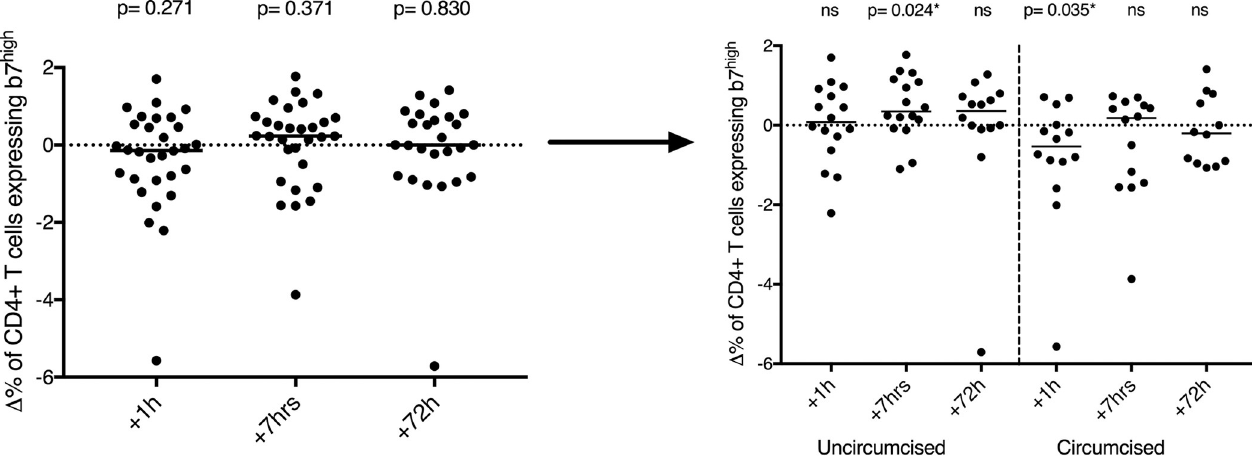
Fig 5. Impact of penile-vaginal sex on blood CD4+ β 7 high T cells. Change ( Δ ) in the proportion of CD4+ β 7 high T cell in blood 1 hour, 7 hours and 72 hours after condomless sex (N = 30). Statistical comparisons were performed using two-tailed Wilcoxon Signed Ranked test.